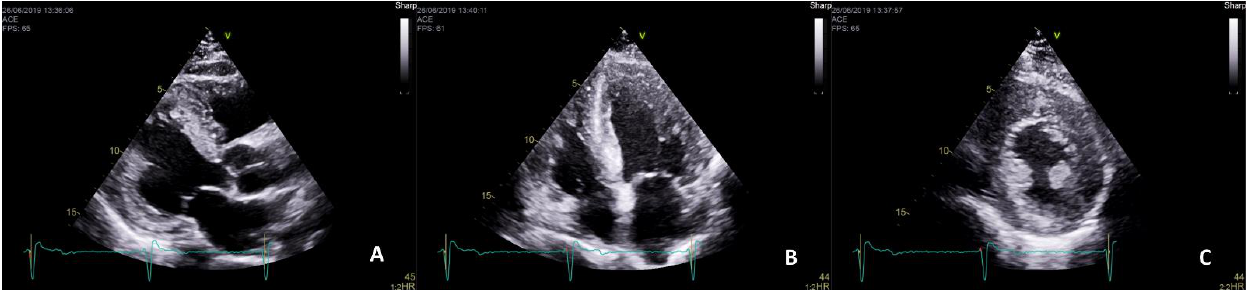
Figure 1. Left ventricular hypertrophy (LVH) secondary to Fabry disease (FD). Transthoracic echocardiogram of a 70-year- old male Fabry patient showing a severe symmetrical LVH with prominent papillary muscles in parasternal long-axis ( A ), four-chambers ( B ) and short-axis ( C )